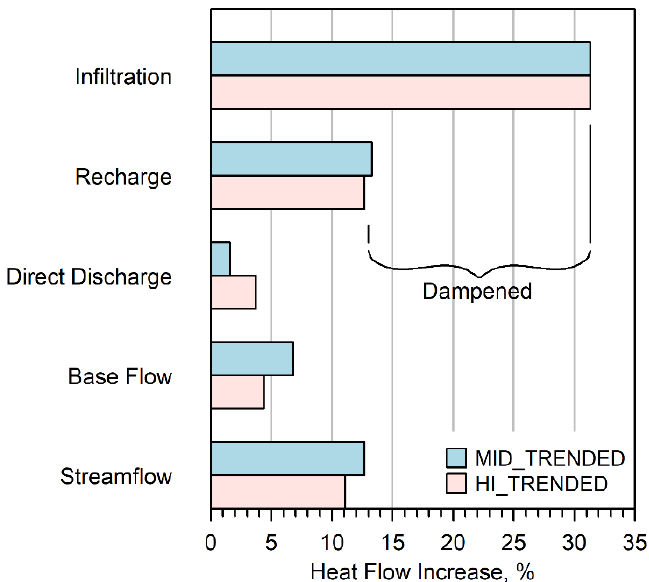
Figure 13. Changes to convective heat flow for different watershed compartments within the simulation are compared for the MID_TRENDED and HI_TRENDED model versions. An increase in heat flow is calculated as the average heat flow over the last 10 years of the of the warming period minus the average heat flow for last year of the spin-up period.